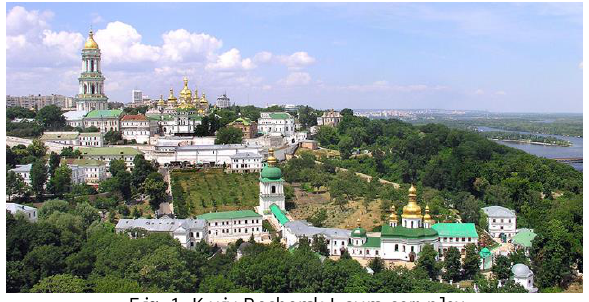
Fig. 1. Kyiv Pechersk Lavra complex